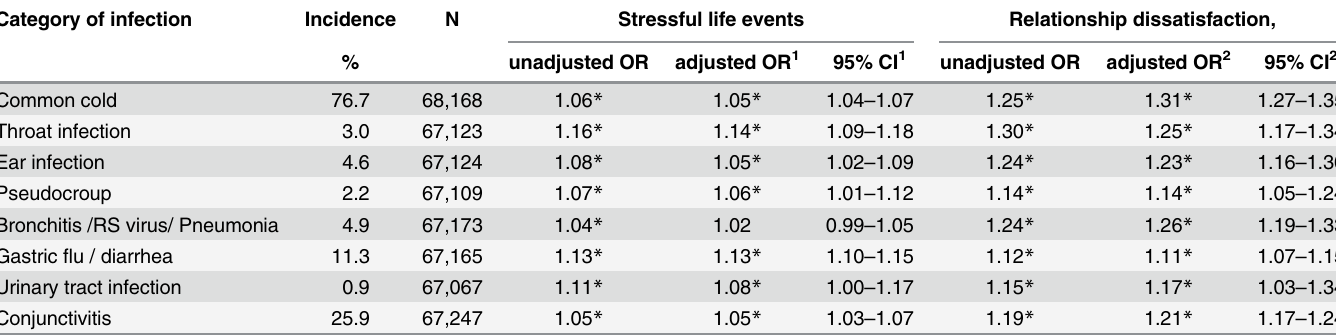
Table 1. Associations between stressful life events and relationship dissatisfaction in pregnancy, and infectious diseases in the less-than- 6-month-old children. Category of infection Incidence N Stressful life events Relationship dissatisfaction, % unadjusted OR adjusted OR 1 95% CI 1 unadjusted OR adjusted OR 2 95% CI